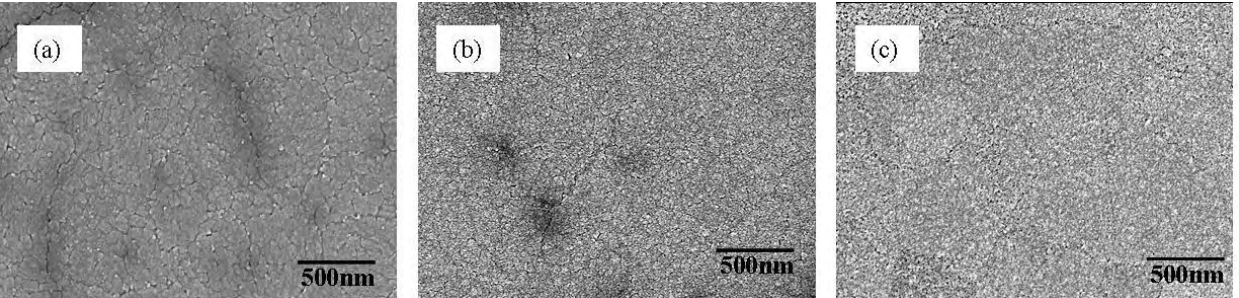
Figure 7. SEM micrographs of 150nm WO